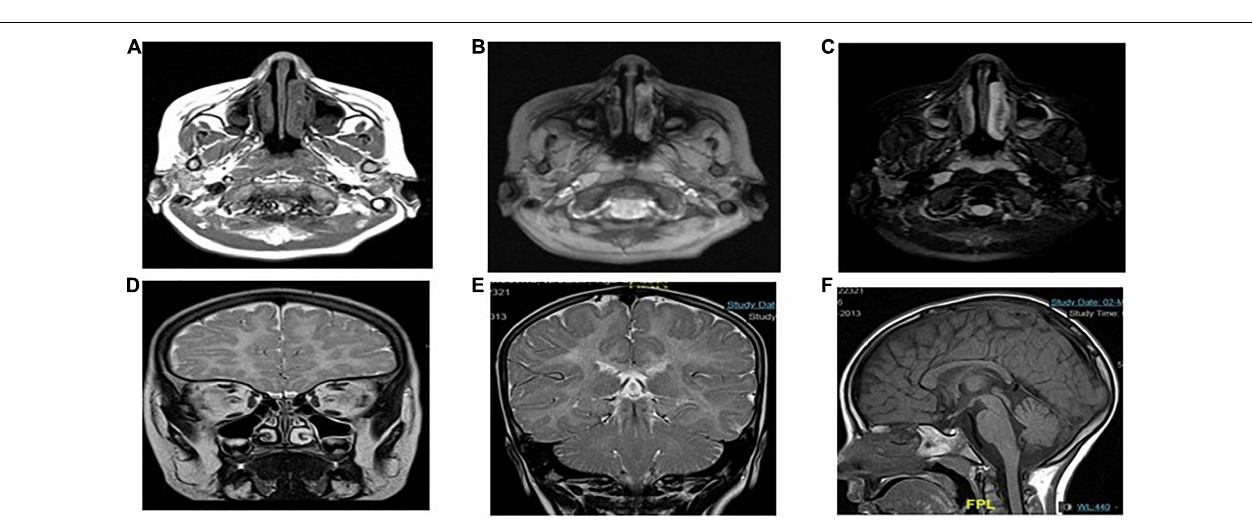
FIGURE 2 | MRI showing the characteristics of POLR1C related leukodystrophy caused by POLR1C variant. Axial T2-weighted (A,B,D,E) and sagittal T1-weighted (F) images of case at the age of 4 years at the time of